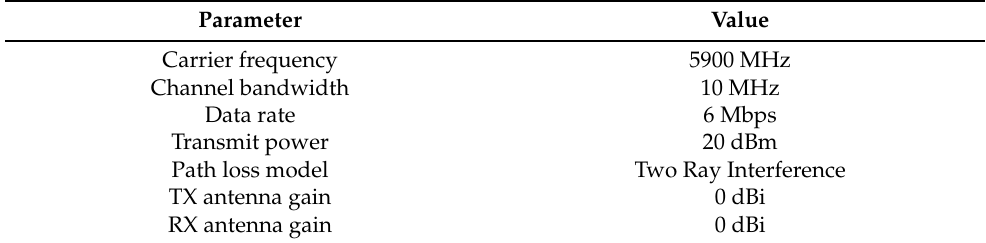
Table 4. DSRC-specific